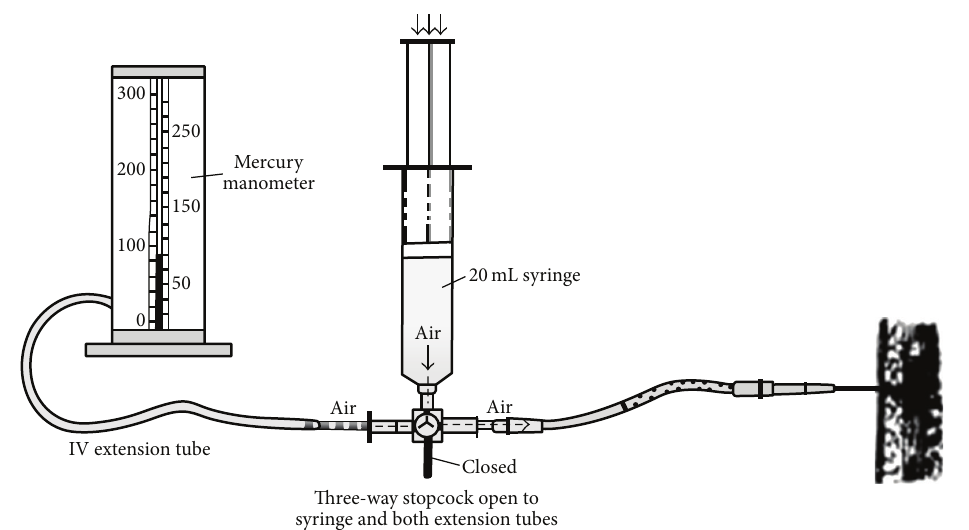
Figure 1: Manual setup for intracompartmental pressure measurement (Campbell Operative Orthopaedics, 11th Edition).